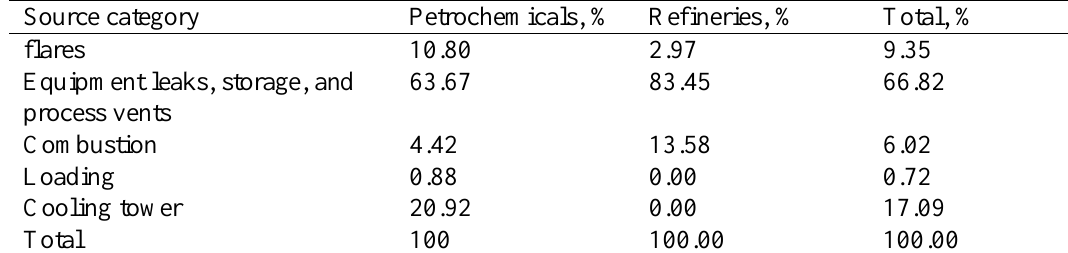
Table 1. Source apportionment of VOCs for five sources categories in the SPZ Source category